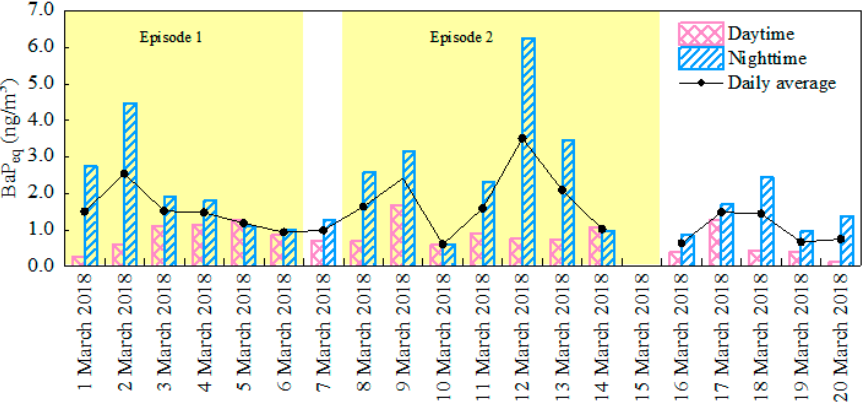
Figure 8. Daily and diurnal variation of BaP equivalent concentration (BaP eq ) mass concentrations in PAHs during the monitoring period.